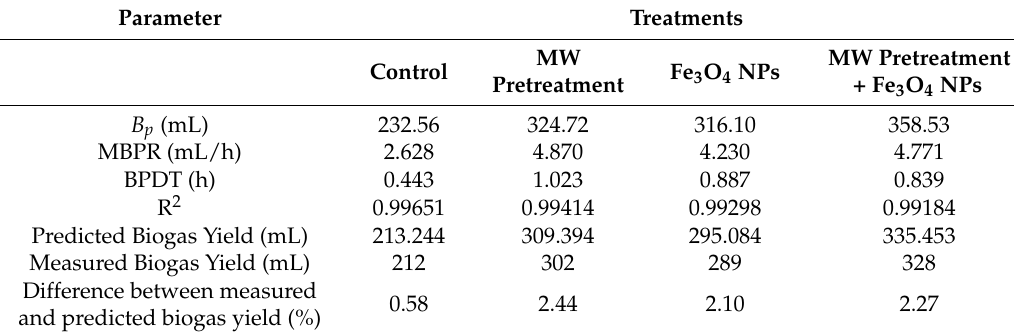
Table 4. Kinetic parameters from the Logistic Function